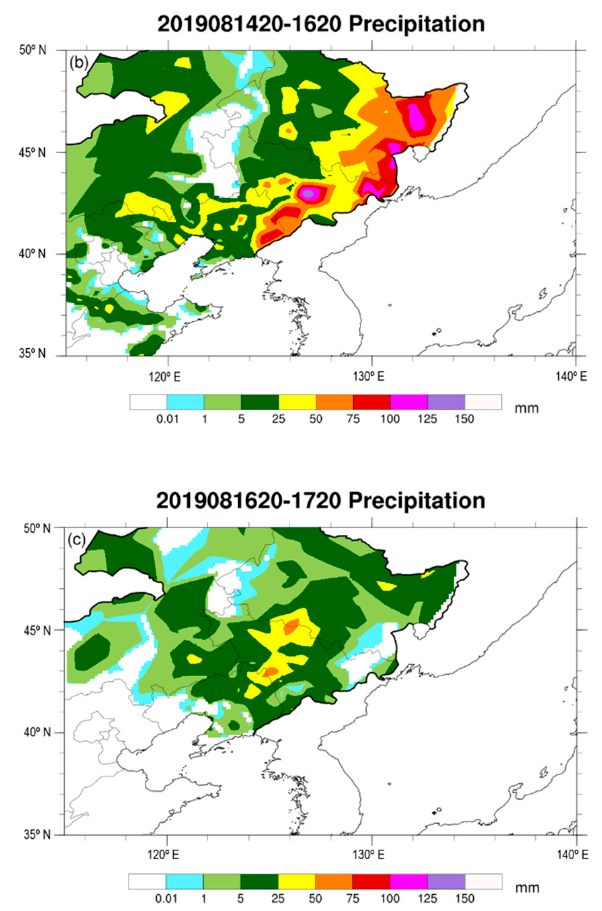
Figure 2. ( a ) Schematic diagram of Typhoon 1909 (Lekima) moving path; ( b ) Accumulated precipitation from 12 UTC 14 August to 12 UTC 16 August 2019; ( c ) Accumulated precipitation from 12 UTC 16 August to 12 UTC 17 August 2019.